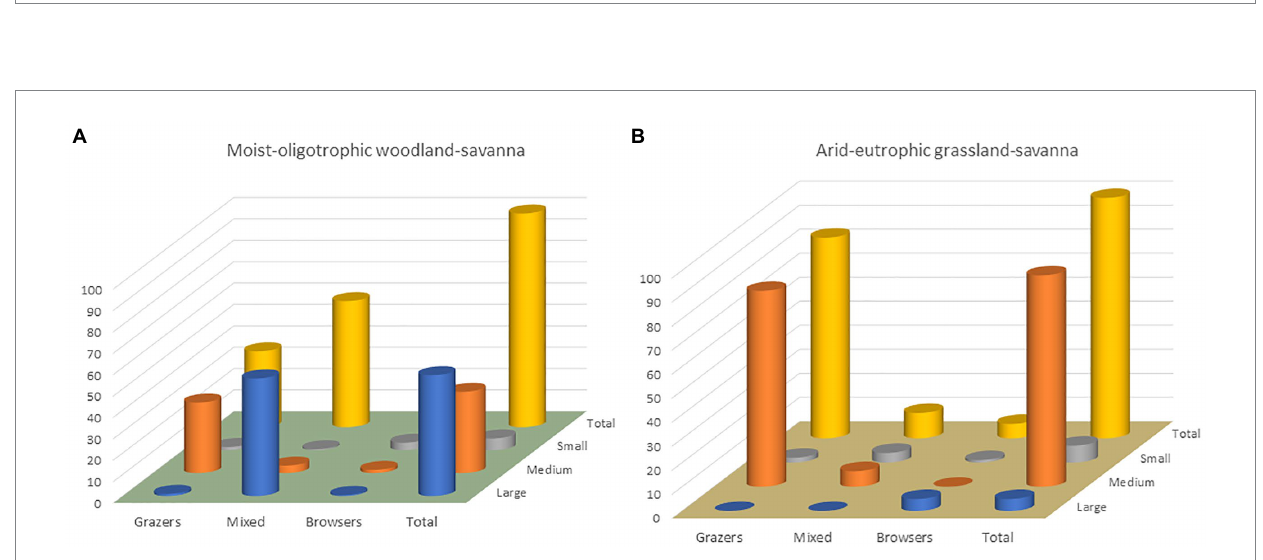
FIGURE 2 Distributions of large-herbivore community biomass (%) among functional types coarsely defined by feeding style (grazer, mixed feeder, browser) and body size (large, >1,000 kg; medium, 100–1,000 kg; small, <100 kg) in two African savanna ecosystems: (A) a moist-oligotrophic woodland and (B) an arid-eutrophic grassland (data from Bell,